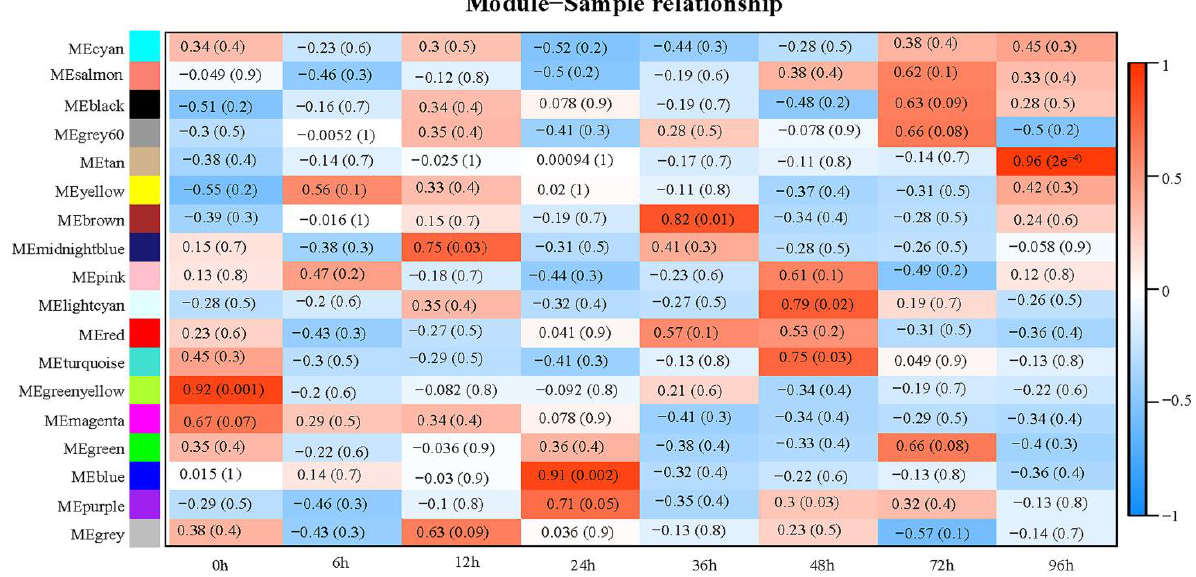
Figure 4. Correlation heatmap between modules and stage of powdery mildew stress. Each row in the table represents a module (indicated on the left), and each column represents a time point to powdery mildew stress (showing below). The table is colored according to the correlation (the p values are shown in parentheses), with a legend on the right.